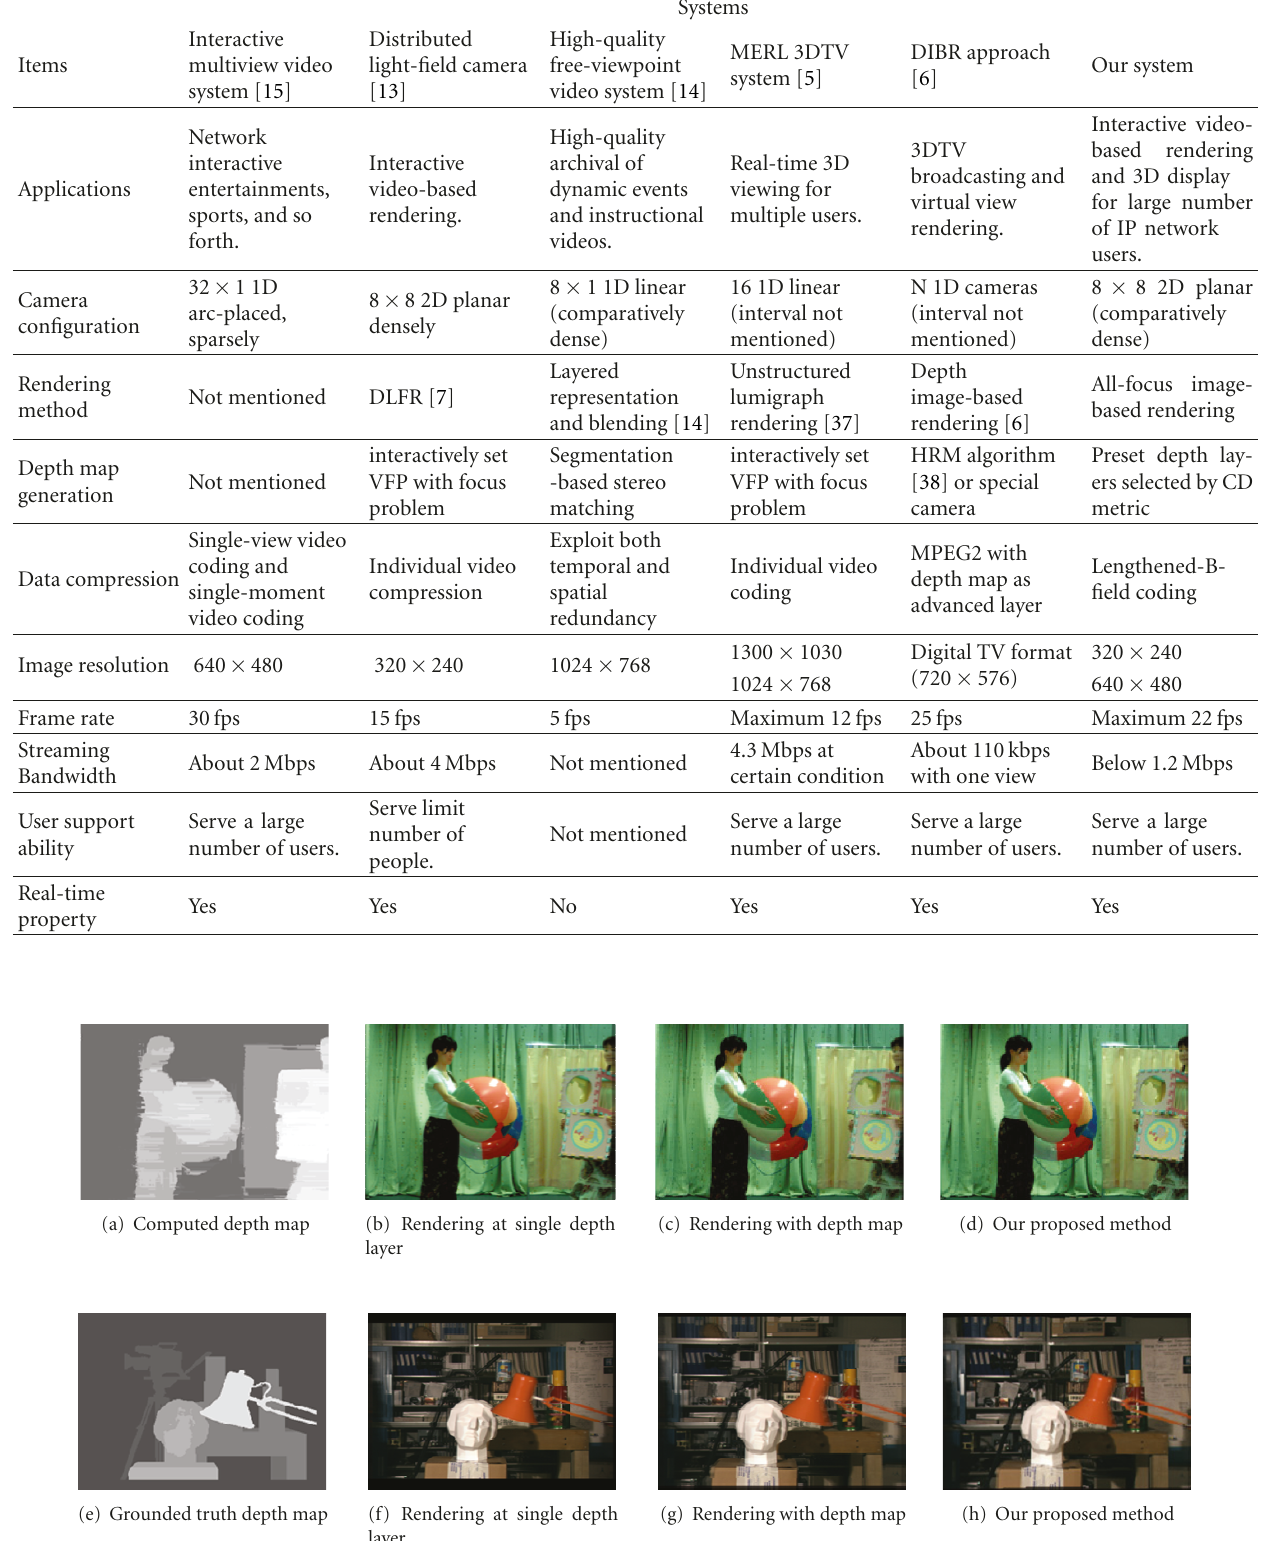
Figure 17: (a)–(d) Comparison on “Akko & Kayo” dataset with computed depth map. (e)–(h) Comparison on “Tsukuba” dataset with ground-truth depth